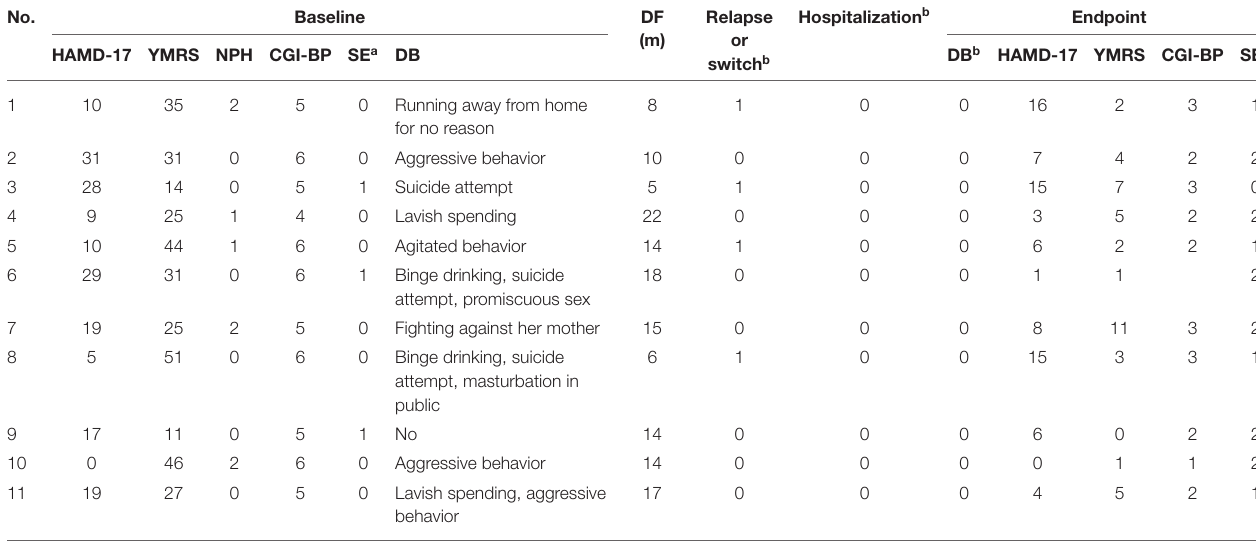
TABLE 3 | Treatment outcome of all the participants. No. Baseline